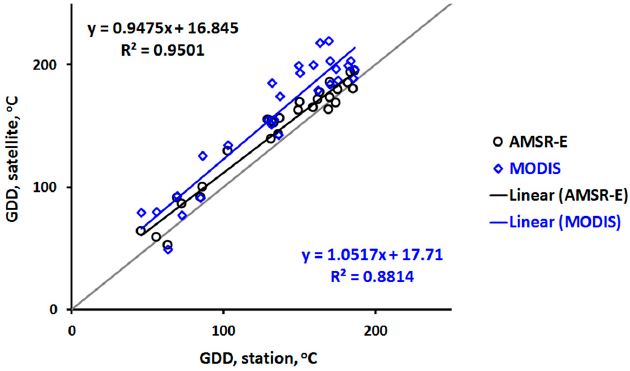
Figure 3. Scatter plots and linear regression fits of station GDD with satellite GDD—AMSR-E GDD (black circles) and MODIS GDD (blue diamonds)—at Simferopol, Ukraine (site 4) for 2003. The linear regression fit for the two datasets were high with r 2 of 0.93 for the AMSR-E GDD and r 2 of 0.89 for the MODIS GDD.